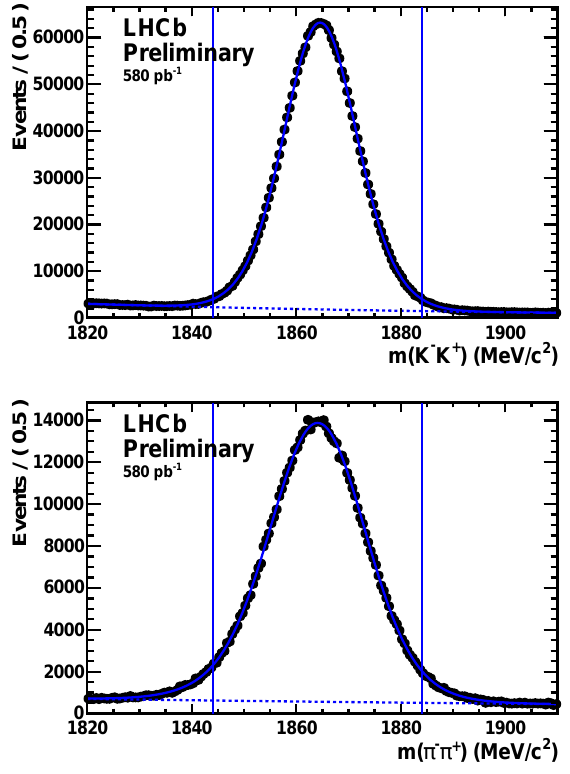
Fig. 1. Fits to the m ( K − K + ) and m ( π − π + ) spectra of D ∗ + candi- dates passing the selection and satisfying 0 < δ m < 15 MeV / c 2 . The vertical blue lines indicate the signal window of 1844– 1884 MeV / c 2